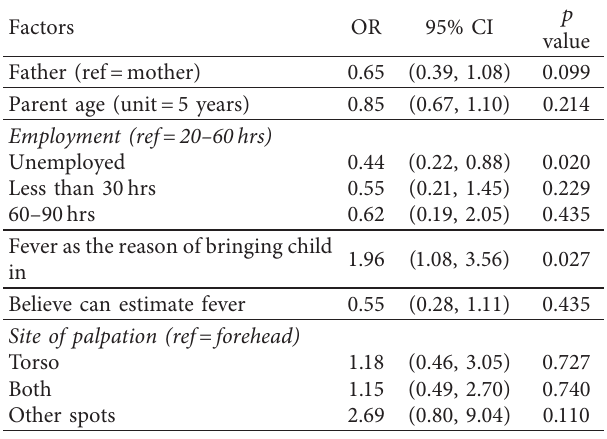
Table 3: Association between variables and identification of fever by palpation ( n � 318).